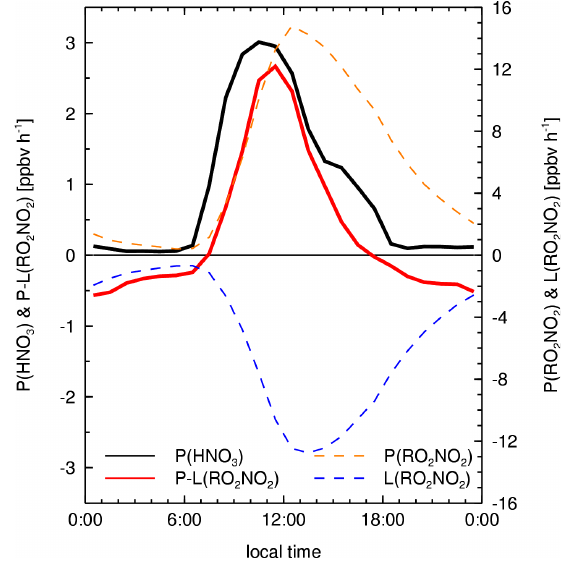
Fig. 4. Average diurnal profiles of net formation rates of RO 2 NO 2 and HNO 3 . Production and loss rates of RO 2 NO 2 are also